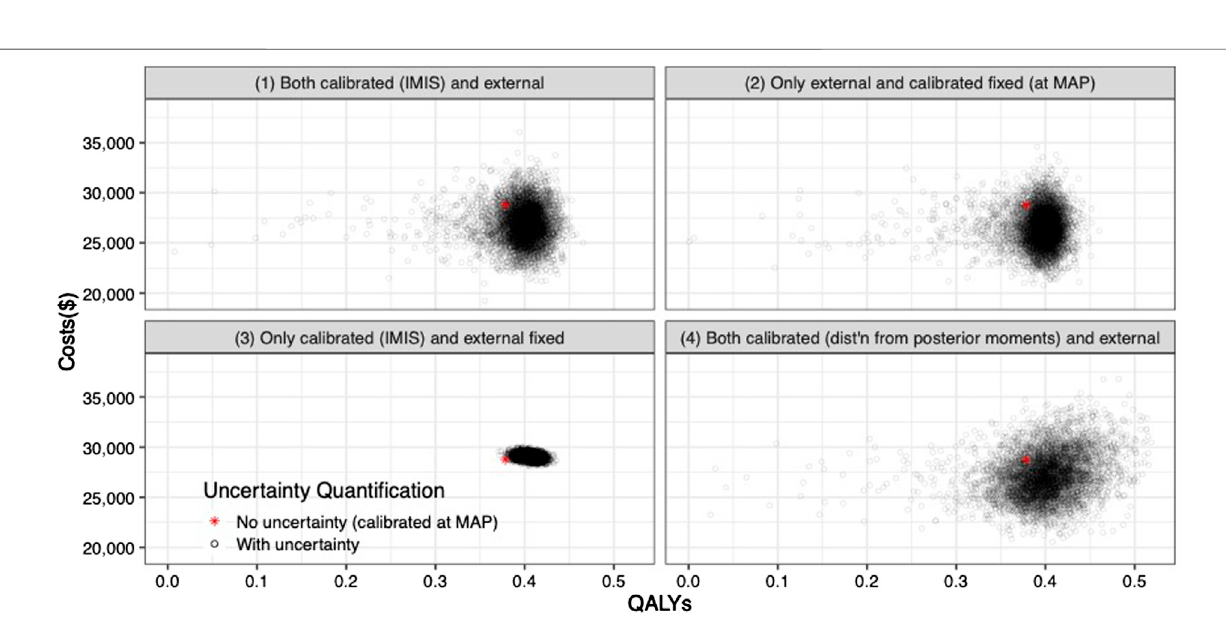
Frontiers in Physiology |